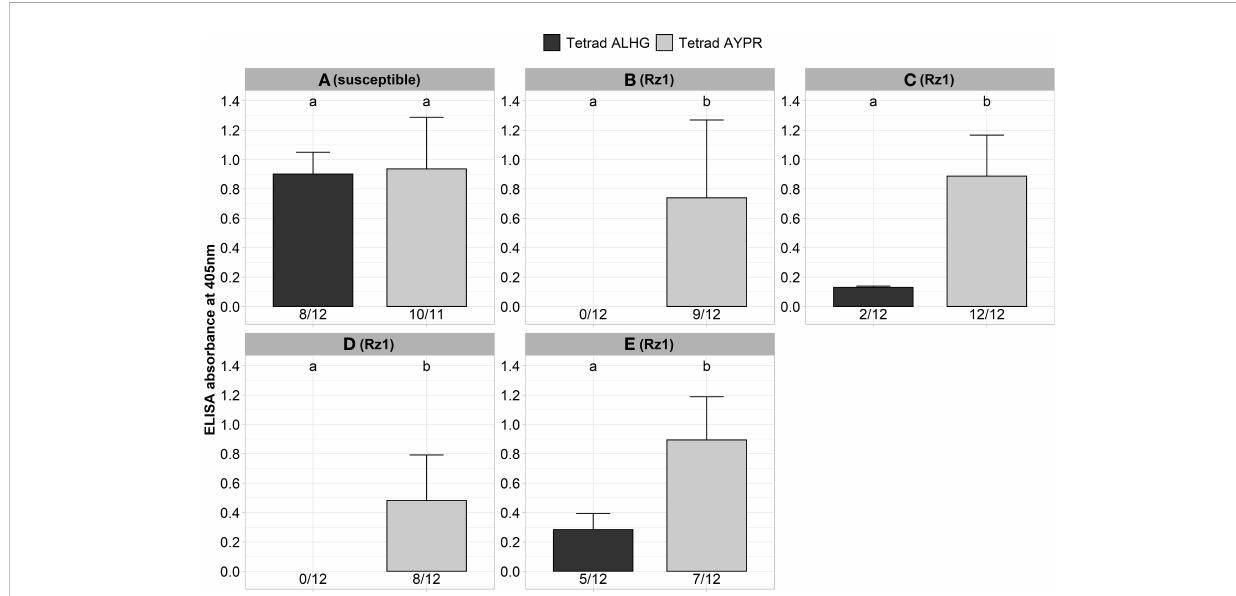
FIGURE 2 ELISA absorbance values for BNYVV measured in lateral roots of plants from a susceptible (A) and different Rz1 resistant sugar beet genotypes [ B – E , Rz1 ] (N=12). Plants were either inoculated with a non-resistance-breaking (BNYVV-ALHG) or with a resistance-breaking (BNYVV-AYPR) clone. Lateral roots were harvested 6 weeks after inoculation. The numbers below each bar indicate the infection rate (infected/inoculated). Mean values were calculated using only infected plants, whereas all values were averaged when no plant was infected. Error bars indicate standard deviation. The healthy controls are not shown because the absorbance values were zero. Signi fi cant differences between both tetrads were determined by the Wilcoxon test and are indicated by small letters (p <